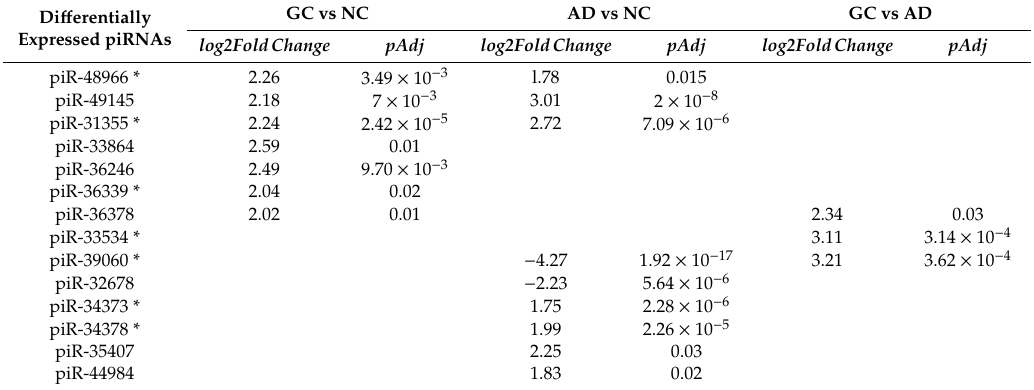
GC vs NC AD vs NC GC vs Di ff erentially Expressed piRNAs